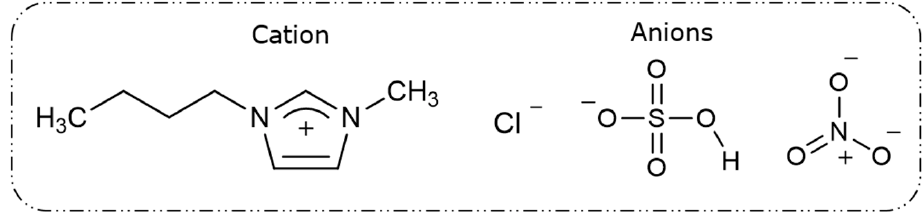
Figure 1. Structures of the cation (1-butyl-3-methylimidazolium–Bmim + ) and different anions (Cl − , HSO 4 − , and NO 3 − ) composing the ionic liquids.